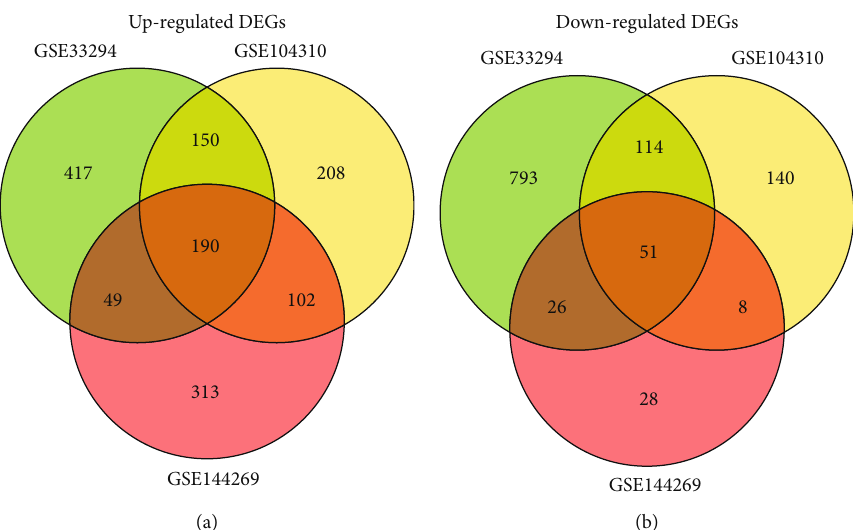
Figure 2: Venn diagram of common DEGs among GSE33294, GSE104310, and GSE144269. (a) Venn diagram shows the common up- regulated DEGs among GSE33294, GSE104310, and GSE144269. (b) Venn diagram shows the common down-regulated DEGs among GSE33294, GSE104310, and